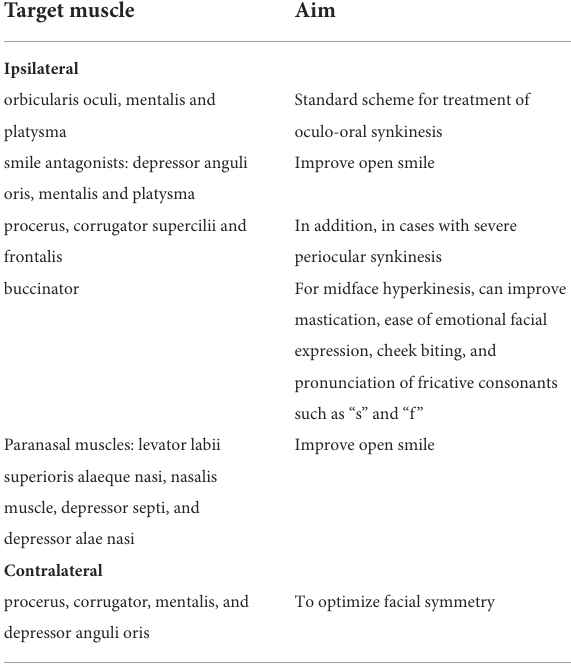
TABLE 5 Typical target muscles for botulinum toxin injections and the effect of the treatment. Target